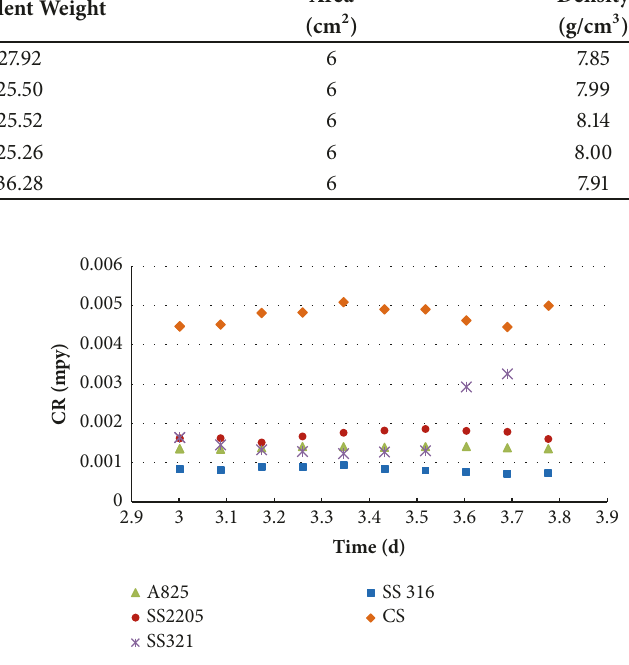
Figure 3:Averagecorrosion ratesversustime for all the testedalloys in stagnant deaerated 3.5% ABS at 60 ∘